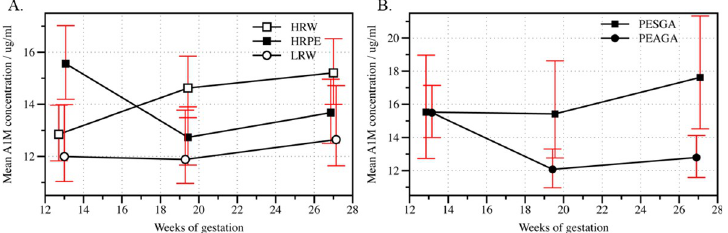
Fig 3. Geometric mean of alpha-1-microglobulin concentration in three study groups and in pre-eclamptic women with small for gestational age and appropriate for gestational age fetus by weeks of gestation. The geometric means of the plasma alpha-1-microglobulin (A1M) concentration by weeks of gestation ( A) among low-risk women (LRW) and high-risk women, who developed pre-eclampsia (HRPE) and among high-risk women who did not develop pre-eclampsia (HRW) and (B) among women who developed pre-eclampsia and gave birth to a small for gestational age infant (PESGA) and to an appropriate for gestational age infant (PEAGA). Red bars indicate 95% confidence